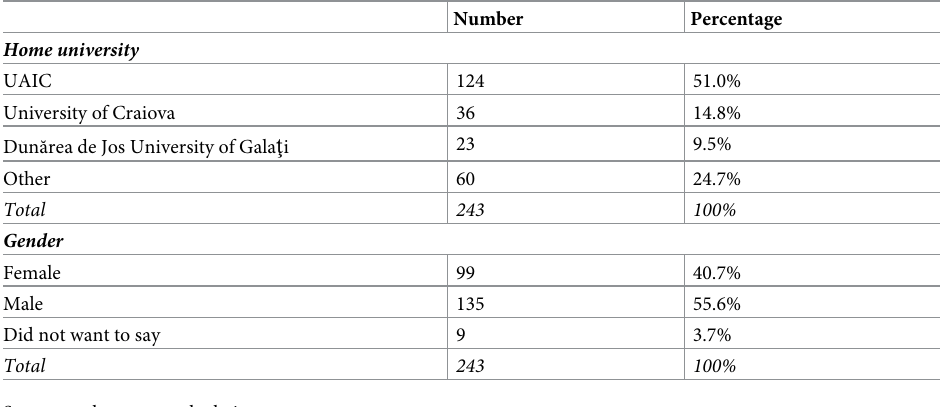
Table 1. The structure of the